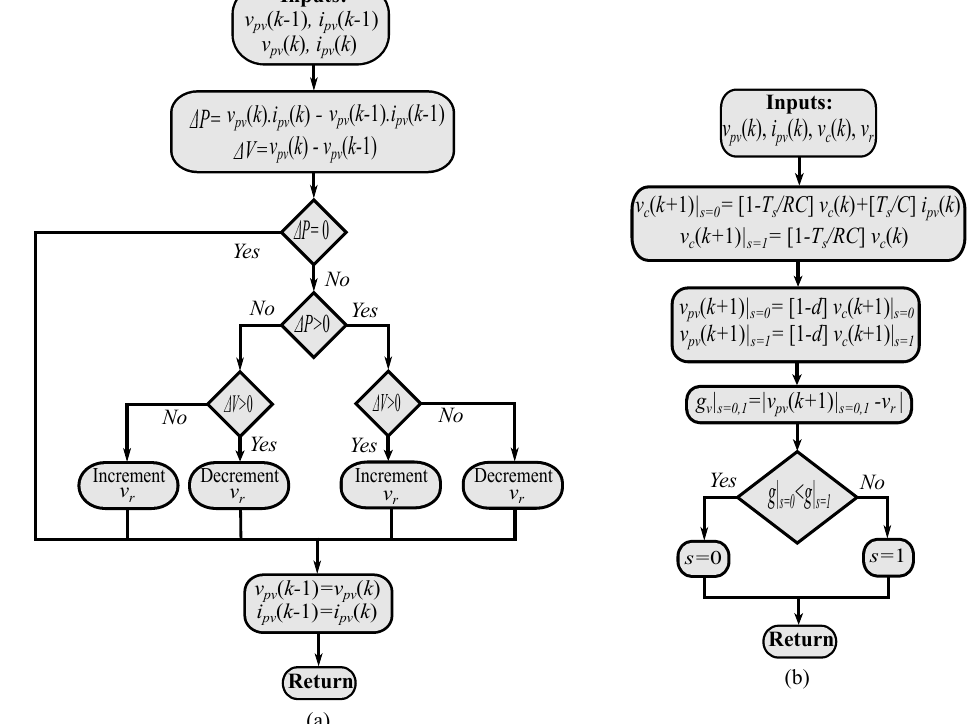
Figure 4. MPPT-based FS-MPC: ( a ) Reference voltage calculation using P&O method. ( b ) Optimal switching state selection-based